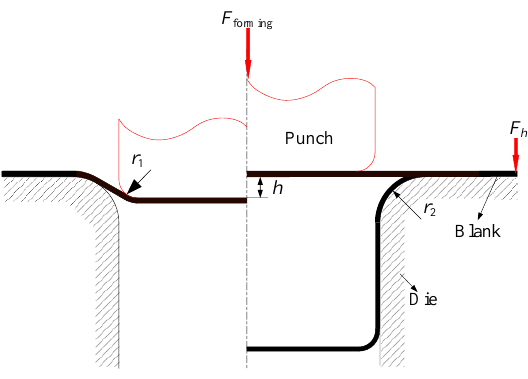
Figure 2. Forming process of hot stamping.